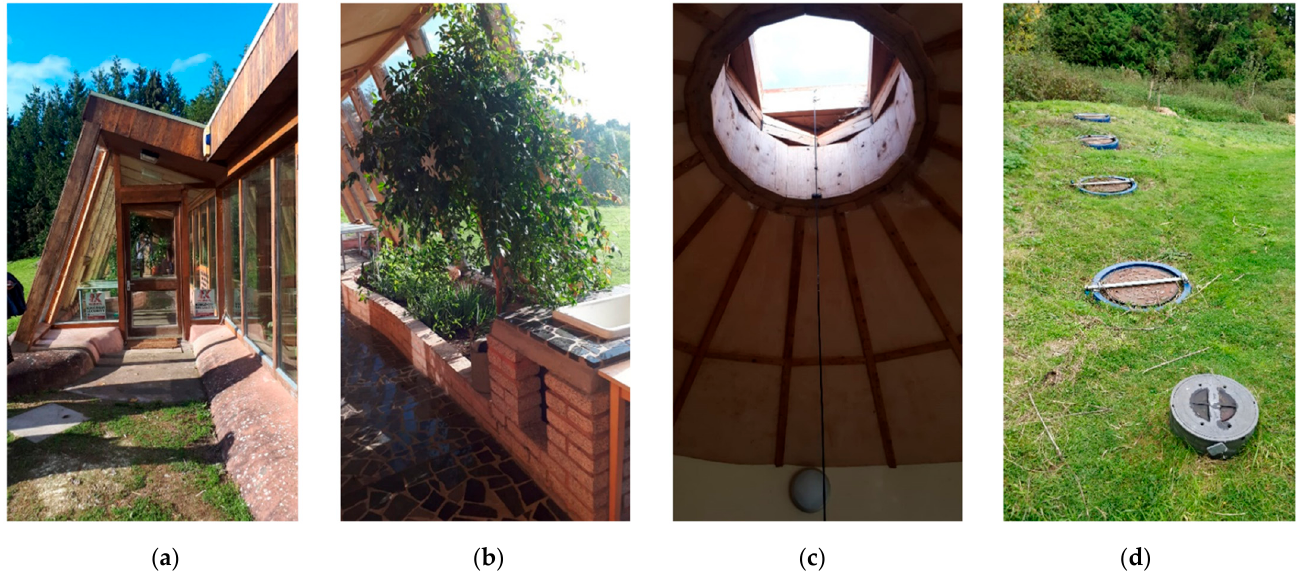
Figure 2. Photos inside and outside of the Brighton Earthship: ( a ) the entrance to the conservatory; ( b ) greywater harvesting system planters inside the conservatory; ( c ) sunlight beaming through the skylight; and ( d ) a collection of underground rainwater storage tanks.